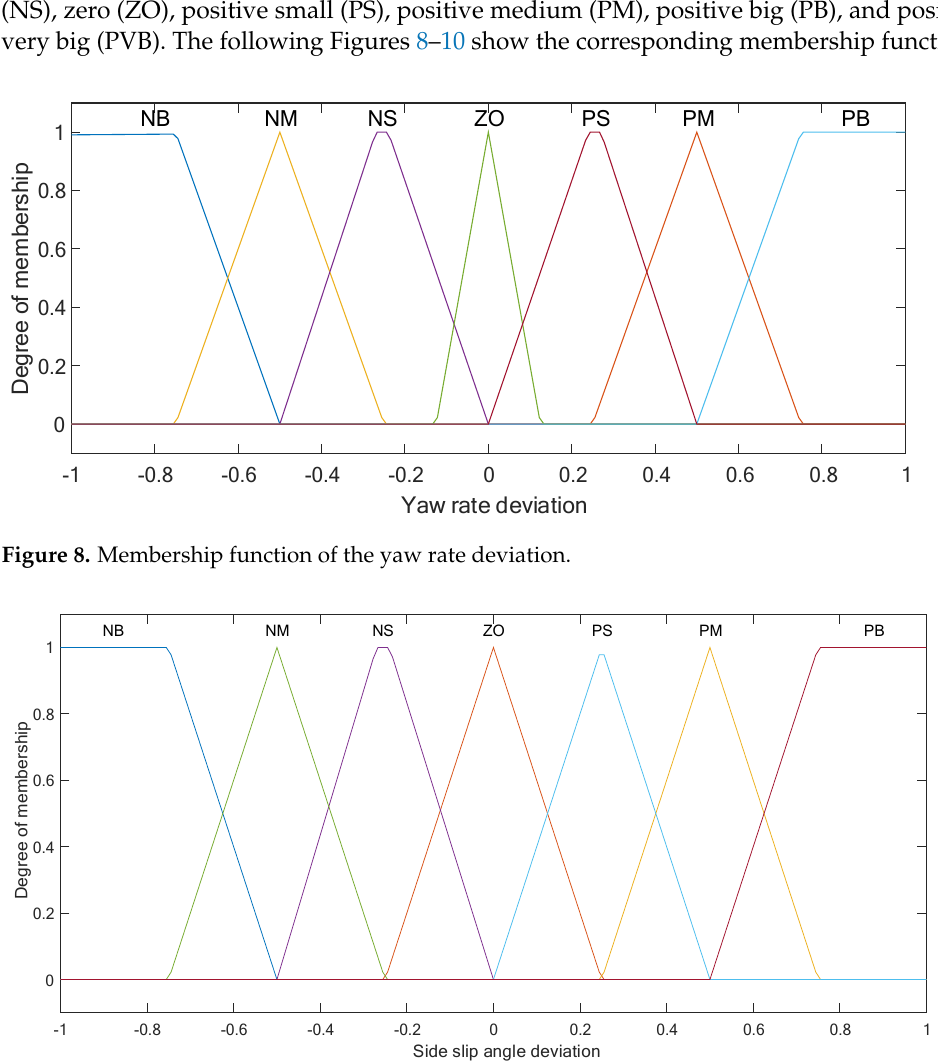
. Figure 10. Membership function of the additional yaw moment. Fuzzy reasoning is the core link in fuzzy control, which is to form a one-to-one rule relationship between the input variable combination of the fuzzy controller and the out- put variable based on expert experience. The reasoning relationships used in this study are shown in Table 2, with a total of 49 fuzzy rules. Table 2. Fuzzy control fuzzy rule table. 𝒆 𝝎 \𝒆 𝜷